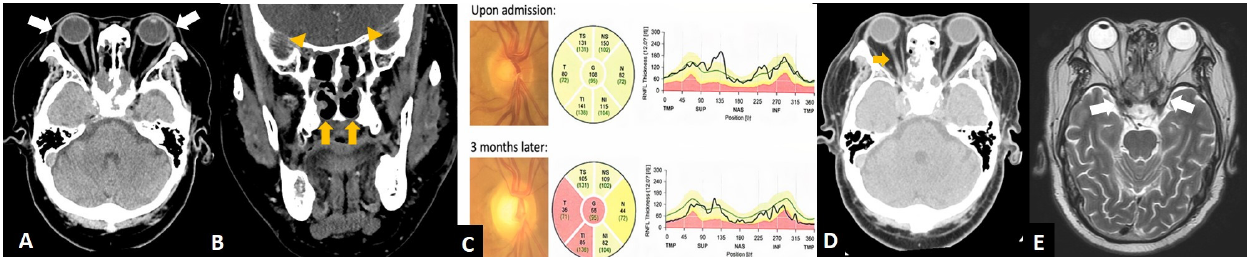
Figure 3. During outpatient clinic follow-up after 3 months, orbital CT showed no dacryoadenitis ( A , arrows). The sinus was clean ( B , arrows), and there was no optic nerve compression. ( B , arrow- heads). Nevertheless, fundus photos at post-operative 3 months showed pale disc and retinal nerve fiber layer loss in the right eye ( C , arrow). Upon the 7-month follow-up, optic atrophy could be noticeable in the CT ( D , arrow) and the inflammation of the orbital apex and cavernous sinus was quiescent in the MRI image ( E , arrows). Eventually, his visual acuity was 20/50 in both eyes at one year mark. Granulomatosis with polyangiitis (GPA), known as Wegener’s granulomatosis previ- ously, is an autoimmune vasculitis notably involving the respiratory tract and the kidney. Involve- ment of the upper respiratory tract accounts for 90% of cases and can cause symptoms of rhinitis, sinusitis, deafness, or epistaxis [1]. Ocular symptoms presented in 30–52% of patients with GPA [1,2] and caused vision loss in 8–37% [1,3]. GPA might cause granulomatous inflammation or vas- culitis involving almost any eye structure, resulting in tarsal–conjunctival diseases, keratitis, episcle- ritis, scleritis, and uveitis [4]. Orbital granuloma accounts for 45% of ocular GPA presentation in the later stage [5]. Our patient did not manifest intra-orbital granulomas, but he suffered from orbital apex complications caused by severe necrotizing sinusitis. The local orbital GPA, if occurred, was usually accompanied by paranasal sinus diseases and bone erosion. Through image studies, the